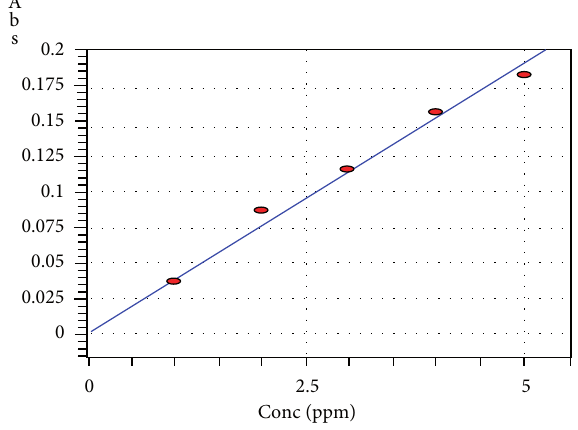
F 9: Calibration curve for Co metal complexes for Atomic Absorption studies. e solutions of cobalt complexes